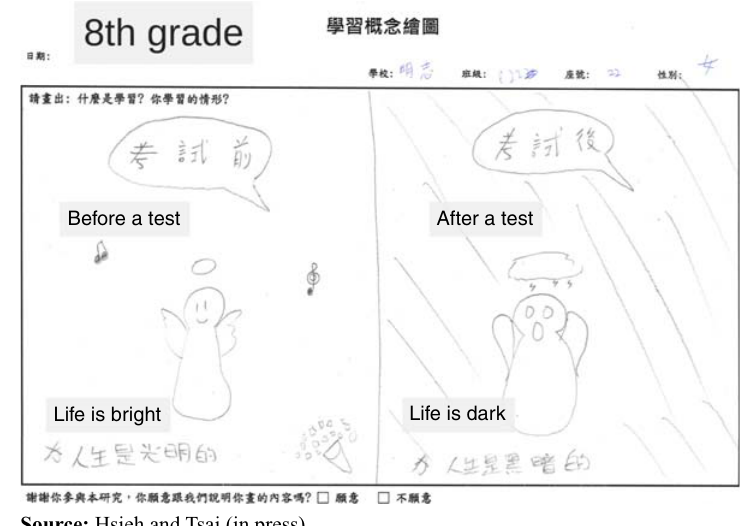
Figure 3. A drawing by an 8th